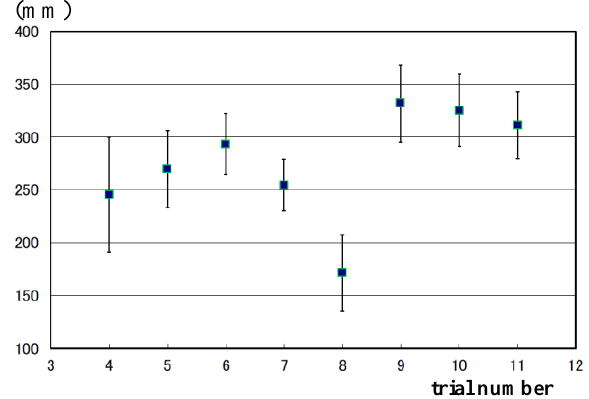
Fig. 6. M oved distance of the flap in 0.2 seconds .